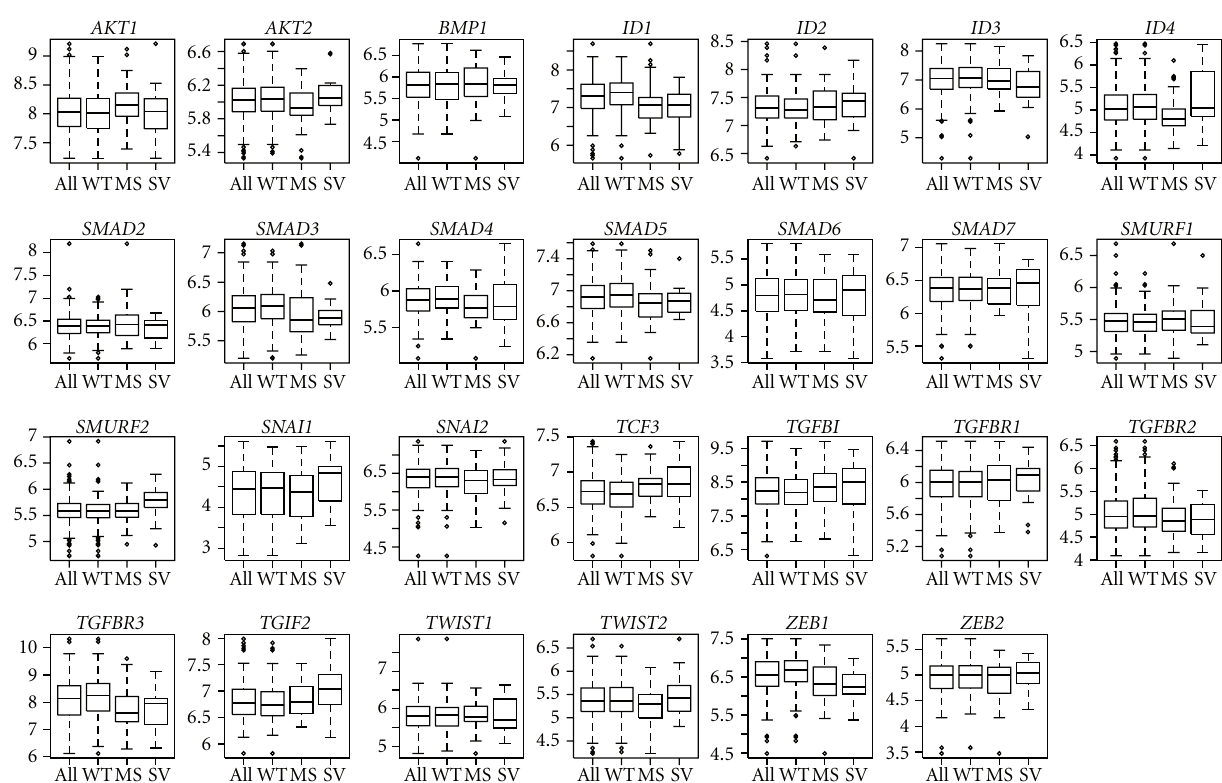
Figure 4: Boxplots of the genes associated with EMT in wild-type (WT), missense (MS), or severe (SV) TP53 mutation with respect to overall case series (all).